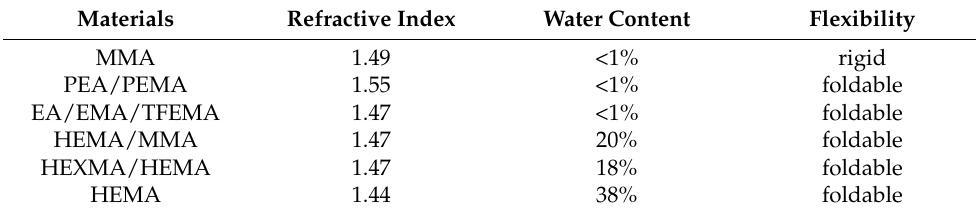
Table 2. IOL-acrylic-based materials. Data from Ref.